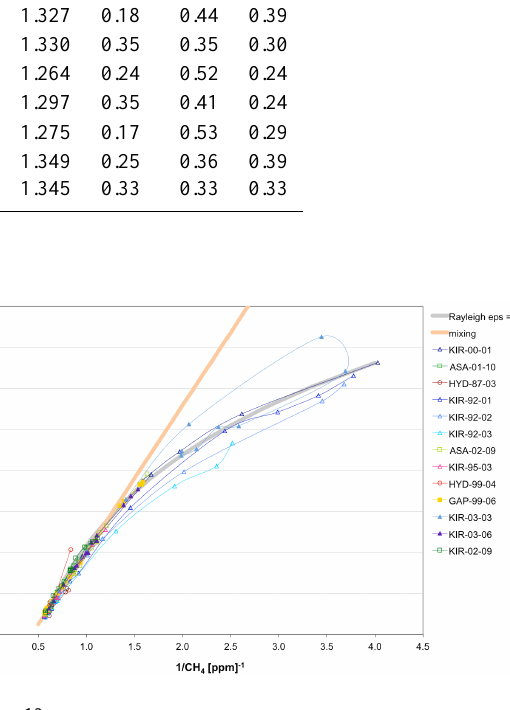
Fig. 8. δ 13 C plotted versus inverse mixing ratio. Mixing of two distinct air masses should result in a straight line in this plot (thick orange line), derived by a linear fit to all samples with mixing ra- tios below 1200ppb, which is approximately equivalent to the high mixing ratio regime of > 200ppb N 2 O (Kaiser et al., 2006). Also shown is a Rayleigh fractionation curve with ε 13 C = 16‰ (thick grey line), a value representative for the vortex flights (Table